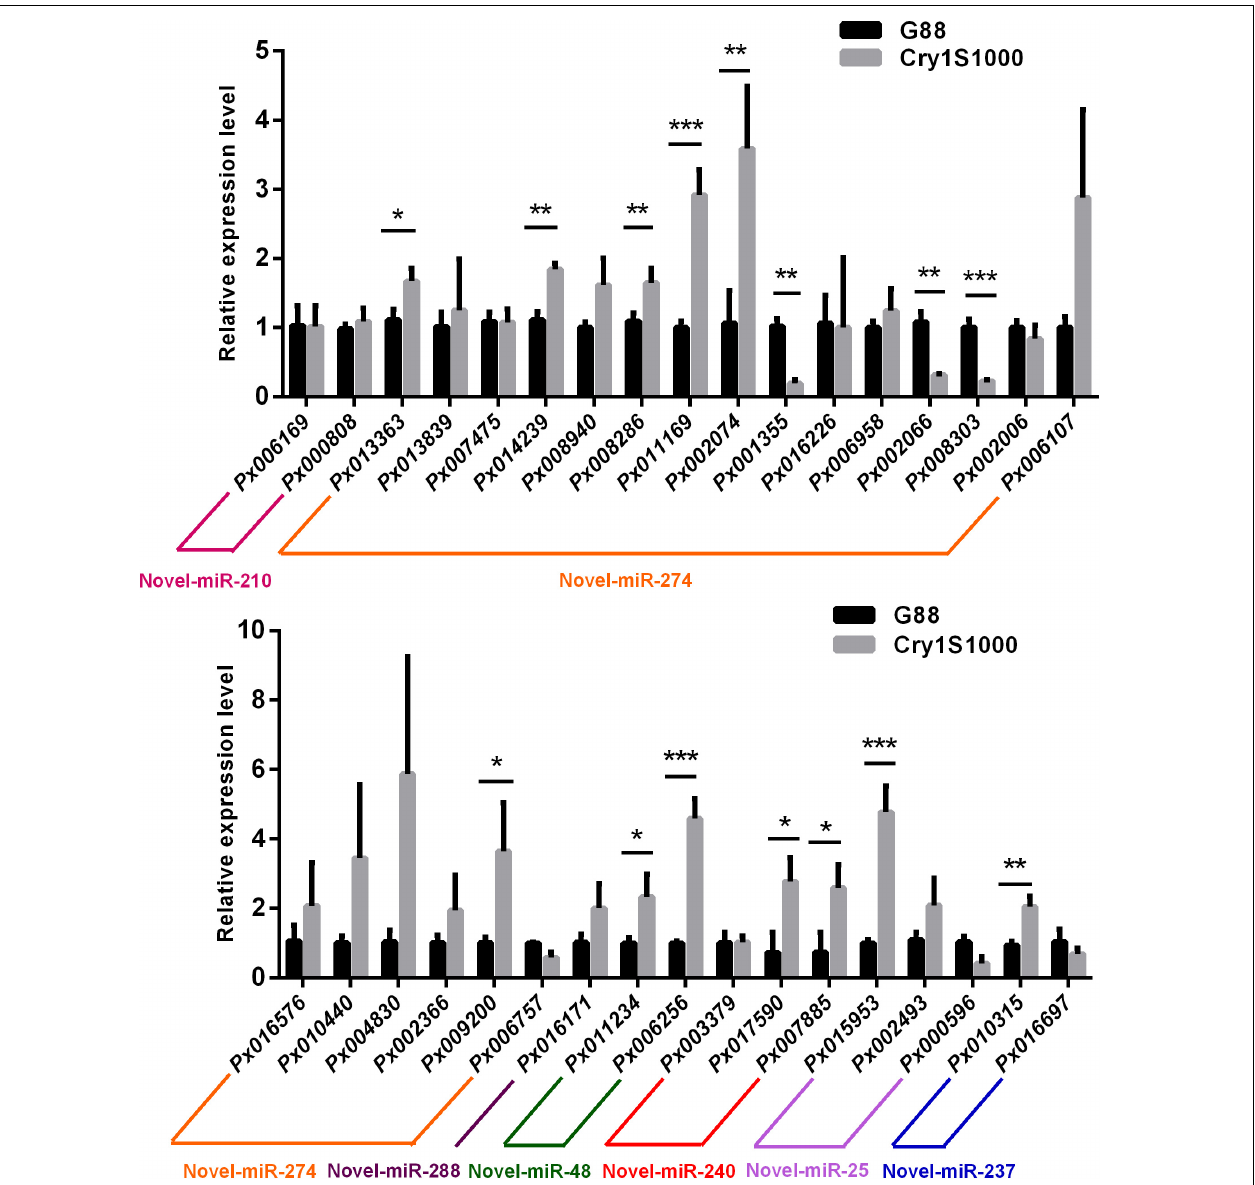
FIGURE 8 | Relative expression levels of target genes in midguts of the resistant (Cry1S1000) and susceptible (G88) strains based on RT-qPCR. The expression levels of target genes were normalized by RPL32 . Statistical significance was analyzed using one-way ANOVA. The asterisks represent significance, where three asterisks indicate p < 0.001, two asterisks indicate p < 0.01, and one asterisk indicates p <